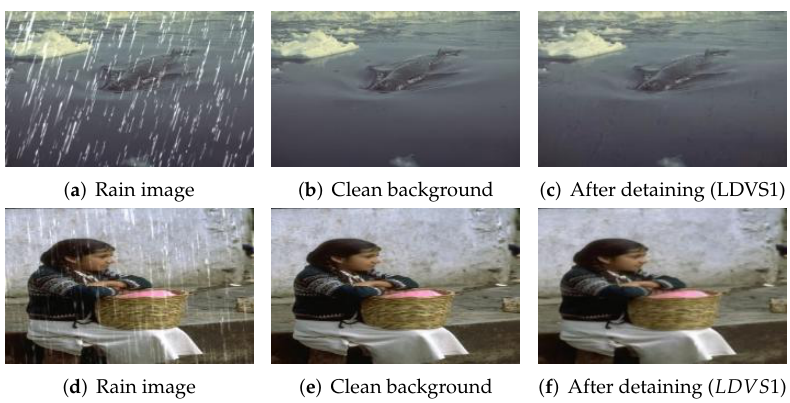
Figure 16. Test results of LDVS 1 on synthetic rain images from Rain 100 L .